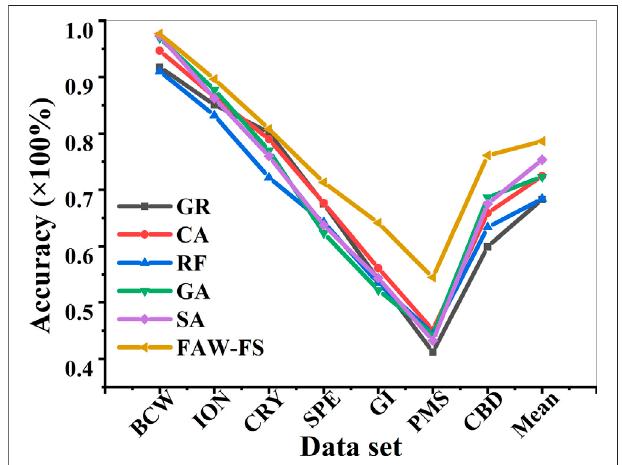
FIGURE 4 | Comparison on the classi fi cation accuracy of different algorithms under the classi fi cation features of DT.